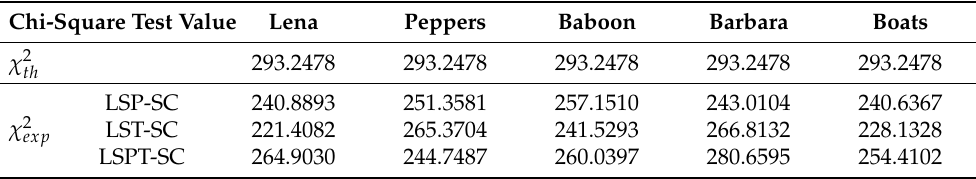
Table 9. Chi-square